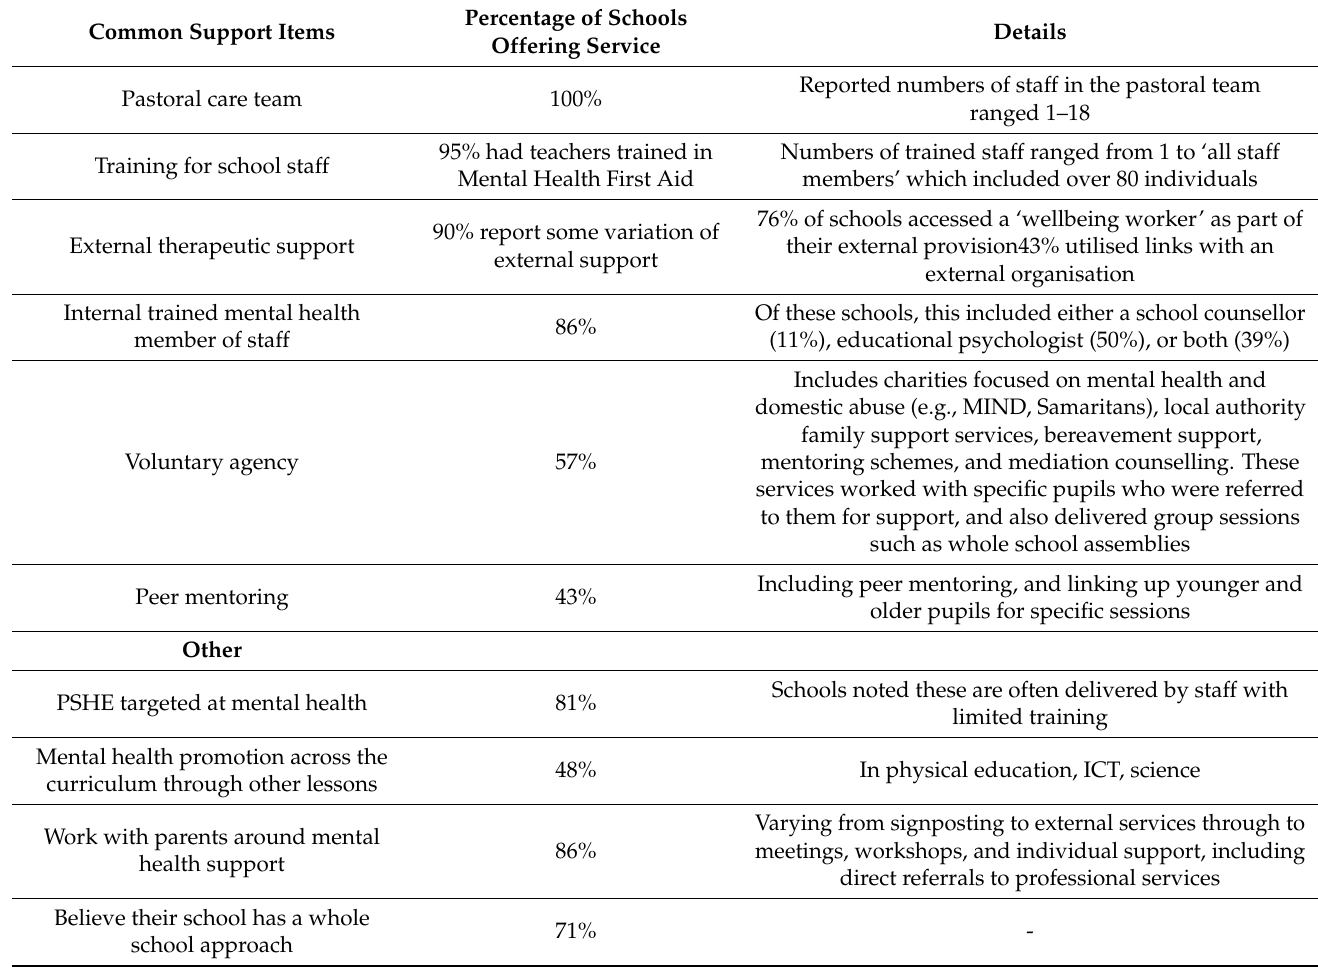
Table 4. Common support